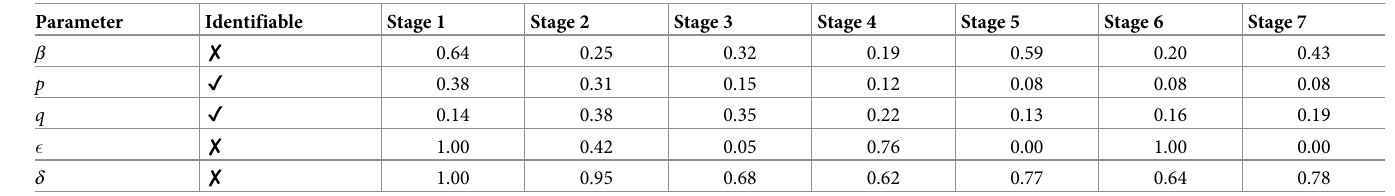
Table 4. Practical identifiability and estimation of parameters when fixing d E , d P , d I , d A , d H , d Q . The symbol ✔ / ✘ means practically identifiable/not identifiable, respec- tively. The fitted values will not be counted towards our final result because the model is not identifiable in this case. Parameter Identifiable